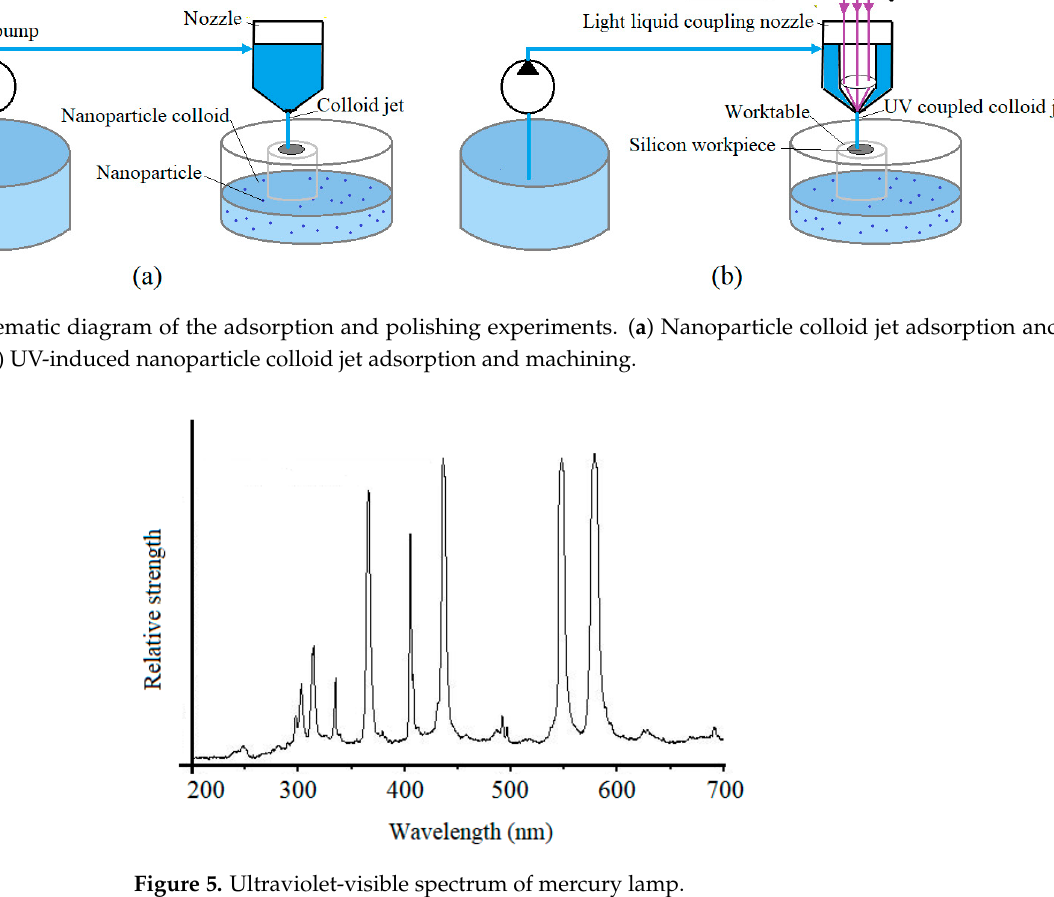
Figure 5. Ultraviolet-visible spectrum of mercury lamp.